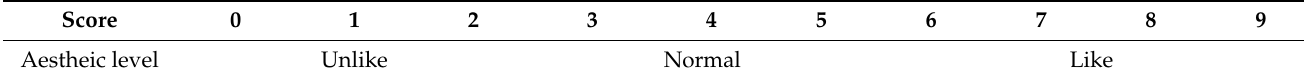
Table 1. Likert scale of 0–9 of the aesthetic